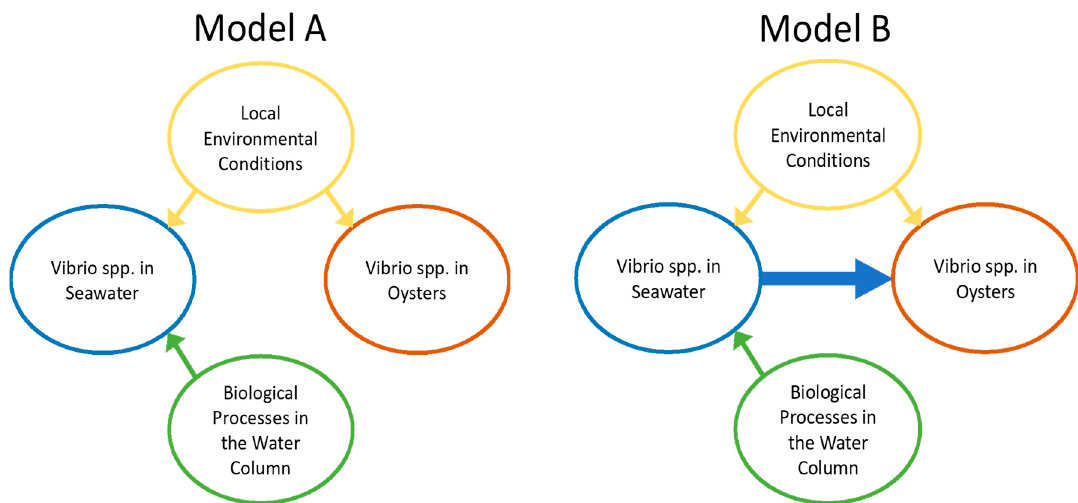
Figure 1. Conceptual model generalizing the expected relationships between environmental factors (e.g., temperature and salinity) and biological processes (e.g., abundance of host organisms and carbon available for decomposition) that drive Vibrio spp. abundance both in the water column and in oysters. Arrows indicate which factors are influencing Vibrio levels in seawater and oysters in each model. Two competing models are represented; Model A ( left ) represents a null expectation that Vibrio spp. in seawater and oysters are driven only by local environmental conditions. Model B ( right ) builds on this expectation by including an additional path representing the case where Vibrio spp. concentrations in oysters respond to concentrations of Vibrio spp. in seawater.